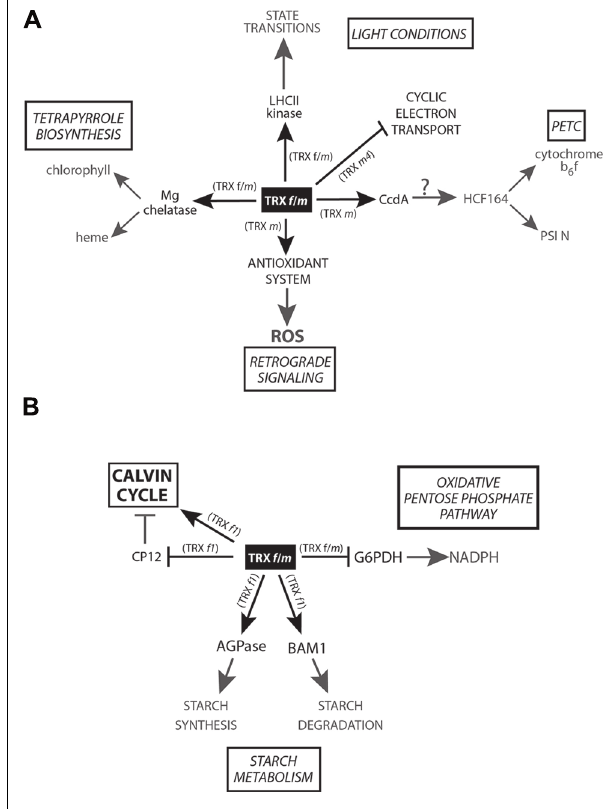
FIGURE 1 | Scheme of theTRX f and m -mediated redox signaling in plastids. (A) Main physiological processes related to photosynthesis and retrograde signaling controlled byTRX f and/or m are shown in the figure. (B) Regulation of carbon metabolism carried out byTRX f and/or m